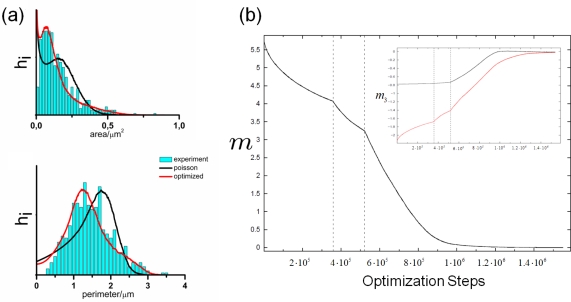
(a) Area (top) and perimeter (bottom) distribution of one of the Al2O3 micrographs of Figure 18 before (black) and after (red) optimization. The bar graphs show the respective histograms of experimental data. (b) Time development of the figure of merit m during the optimization for the structure of (a). After 358000 and 512000 optimization steps, the maximum step size of the reverse MC algorithm (changing the position of a generator point) was increased, which shows a direct influence on the speed of optimization. After 1.5 million steps the deviation between the model and experiment has dropped below 1.3 × 10−4. The inset shows the corresponding time development of m of the perimeter (red) and (area) distribution of the third central moment.